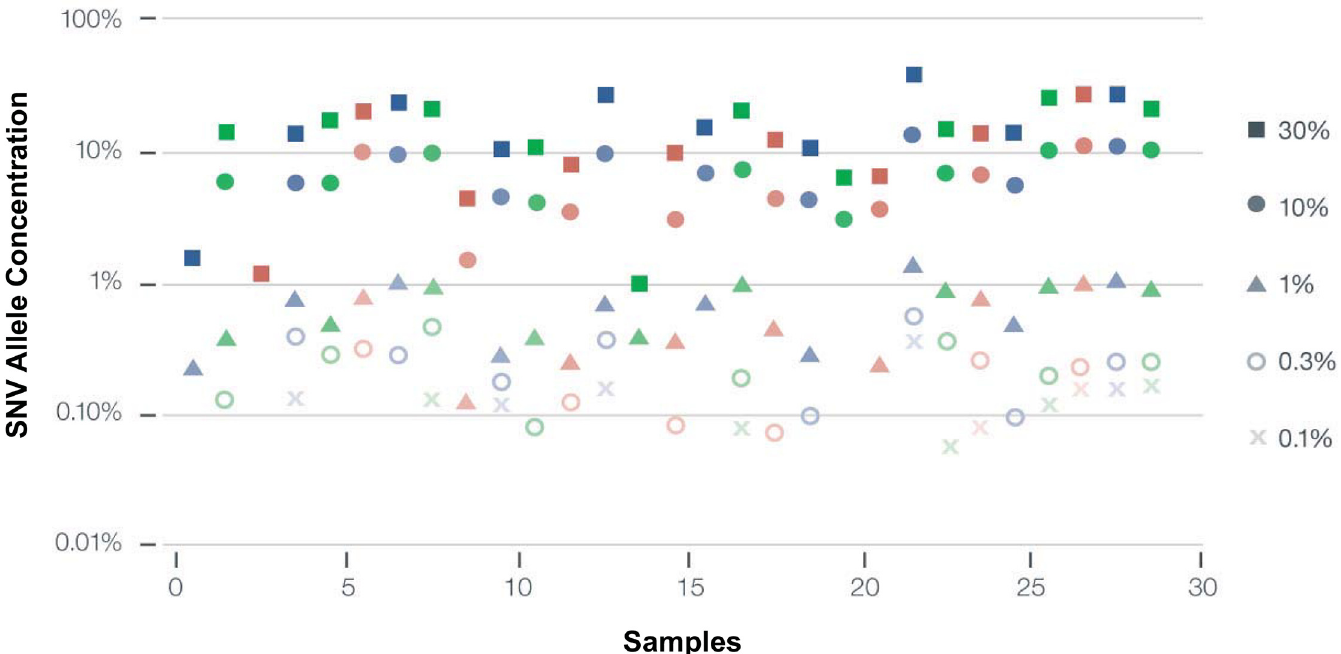
Fig 4. Analytic Sensitivity of the Guardant360 digital sequencing method. Twenty nine SNV samples were diluted serially until they could no longer be measured with the assay. Each column represents successively greater serial dilutions of a given sample. The limit of detection (LOD) was 0.25% mutant allele frequency or fraction) (MAF), defined as the percentage at which > 80% of samples were detected. Note that almost 30% of samples were additionally detected at 0.1% MAF or lower, where 0.1% represents a single mutated DNA fragment out of 999 wild-type (leukocyte-derived) DNA fragments overlapping the same nucleotide base.